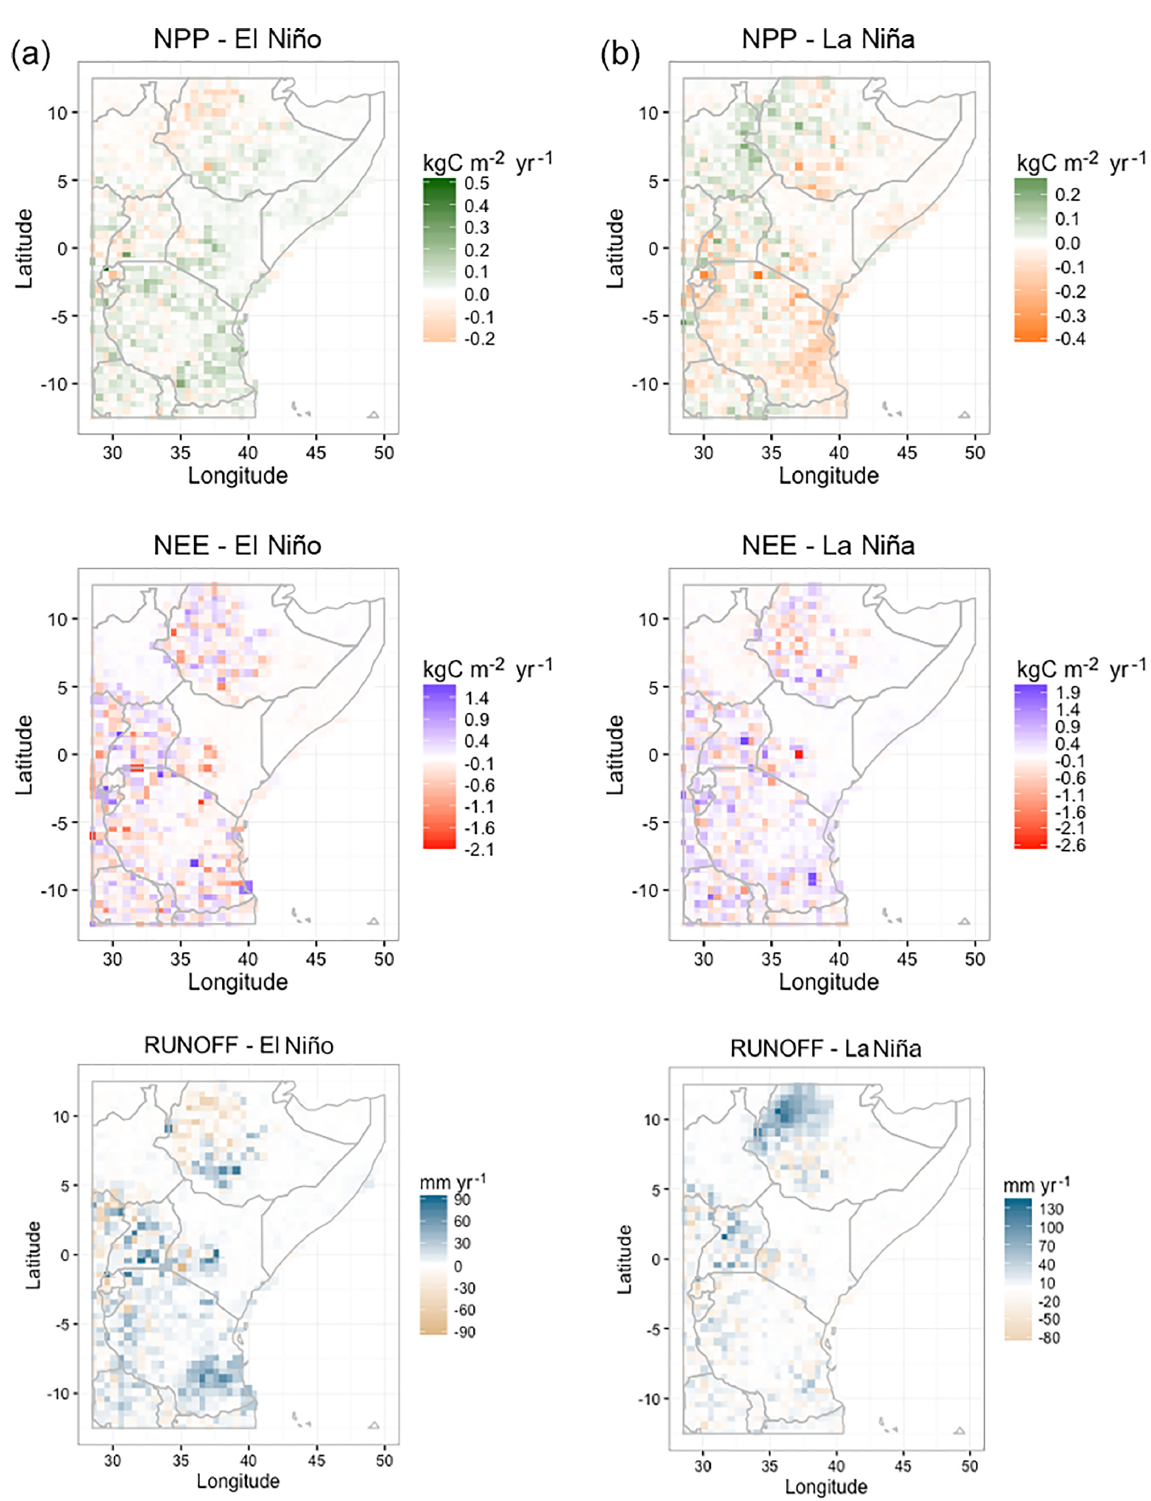
Figure 4. Simulated future differences in the NPP, NEE, and RUNOFF between, with, and without intensified ENSO runs. (a) Mean differ- ences for the strong El Niño years ( ≥ + 1 . 5 ◦ C) (2025, 2026, 2077) were calculated by subtracting the GCM-ensemble-driven simulations without modification from the GCM-ensemble-driven future simulations with an intensified ENSO signal. (b) Same for strong future La Niña events ( ≤ − 1 . 5 ◦ C) (2039, 2049,